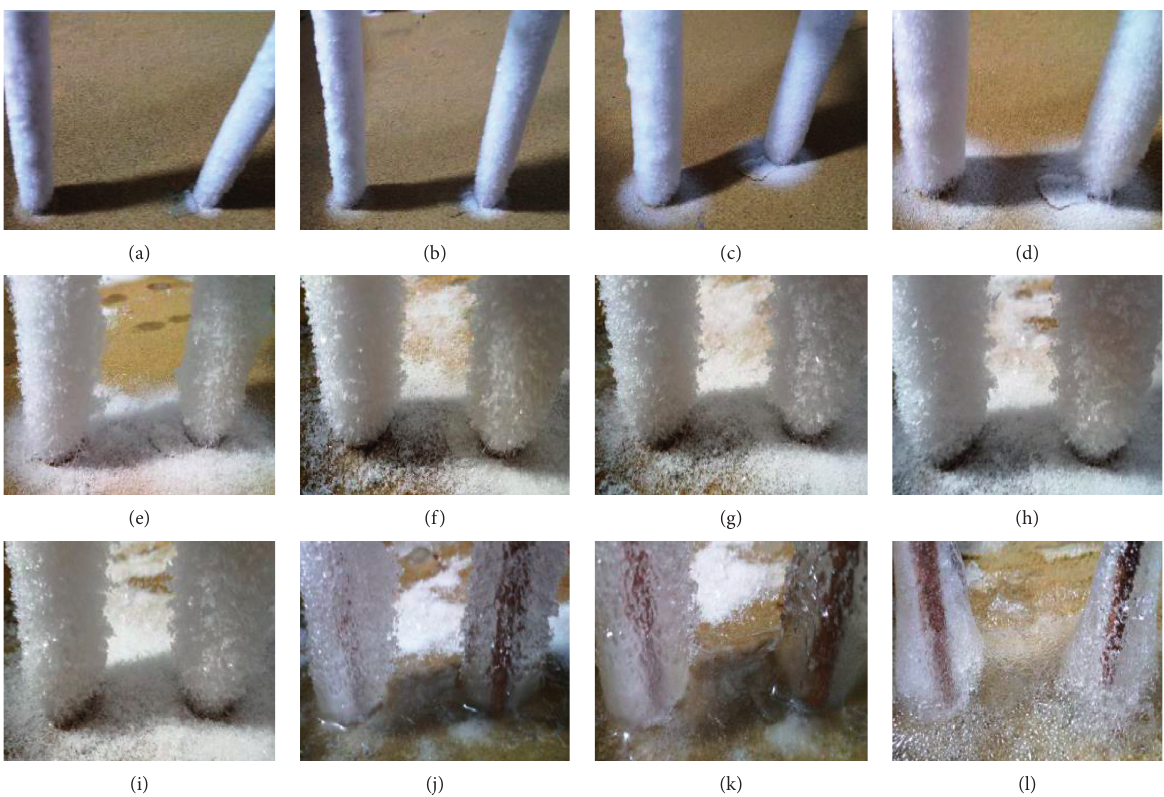
Figure 8: Surface intersection of frozen wall. (a) Boot 2 h. (b) Boot 4 h. (c) Boot 8h. (d) Boot 10h. (e) Boot 24 h. (f) Boot 48h. (g) Boot 72h.